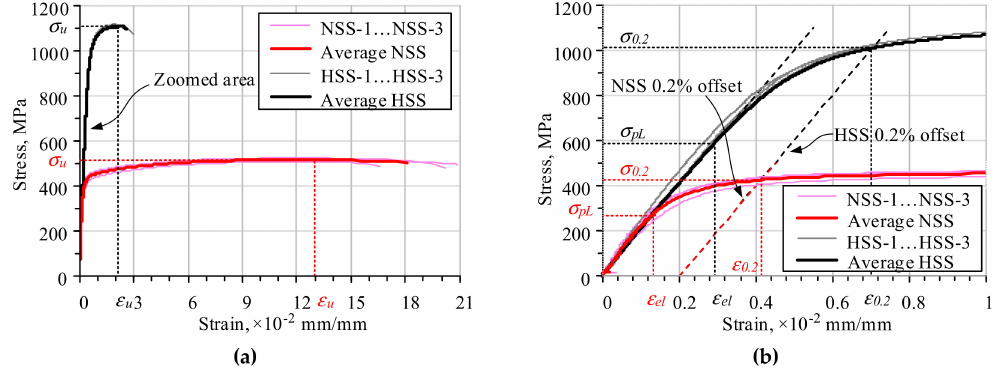
Figure 2. Stress–strain relations of flat tensile coupons of NSS and HSS: ( a ) actual graphs; ( b ) initial part of the